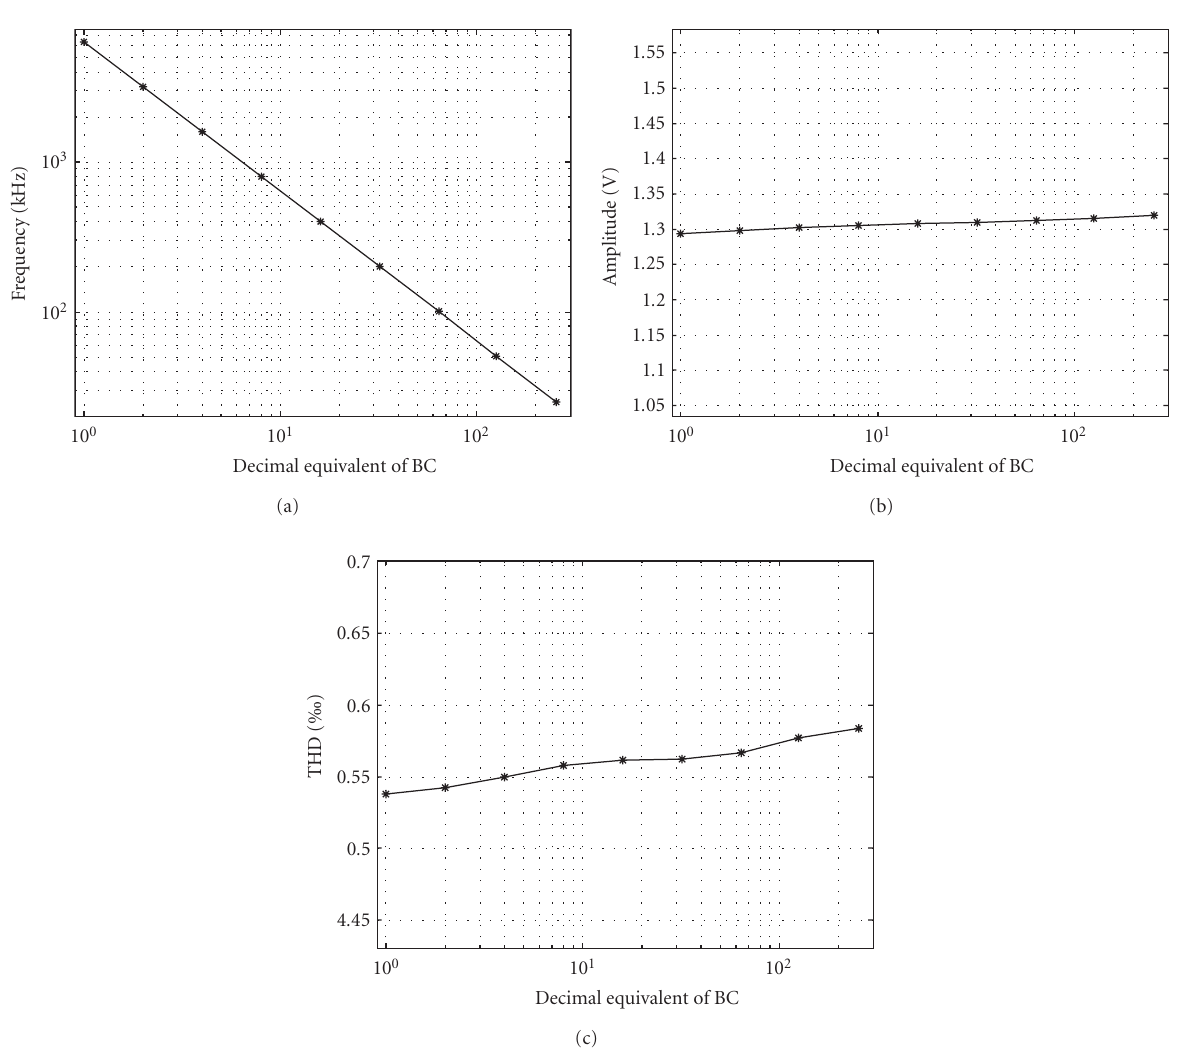
Figure 8: (a) FO tuning, (b) amplitude variation, and (c) THD variation, with changing